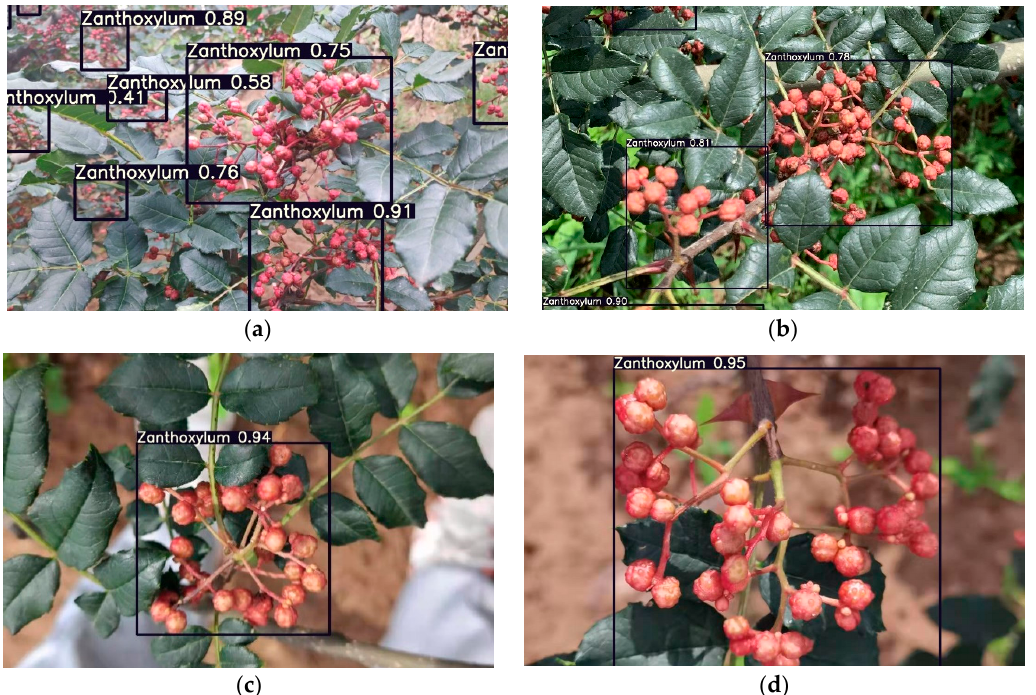
Figure 12. Recognition results of Zanthoxylum by the improved YOLOv5s network in the afternoon. ( a ) Multiple clusters of blocked Zanthoxylum fruit. ( b ) Multiple clusters of unblocked Zanthoxylum fruit. ( c ) Single cluster of Zanthoxylum fruit under backlight. ( d ) Single cluster of Zanthoxylum fruit under sunlight.